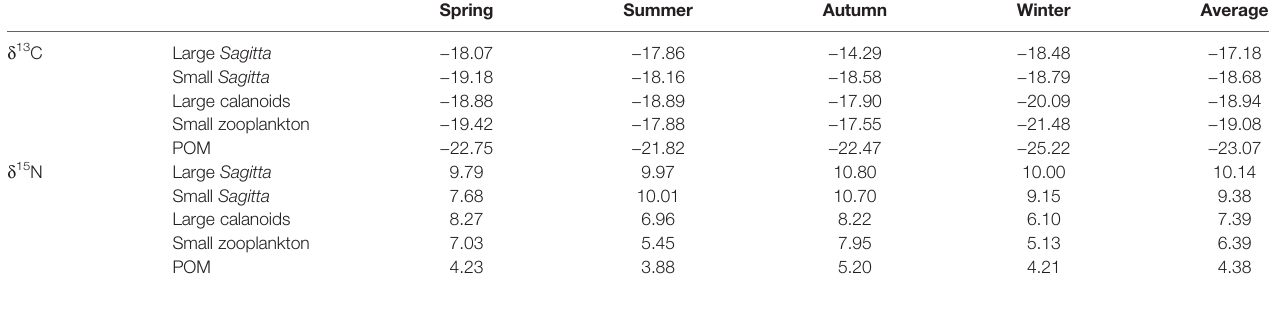
TABLE 1 | Seasonal average values ( ‰ ) of d 13 C and d 15 N in dominant zooplankton groups and suspended particulate organic matter (POM) in Jiaozhou Bay. Spring Summer Autumn Winter Average